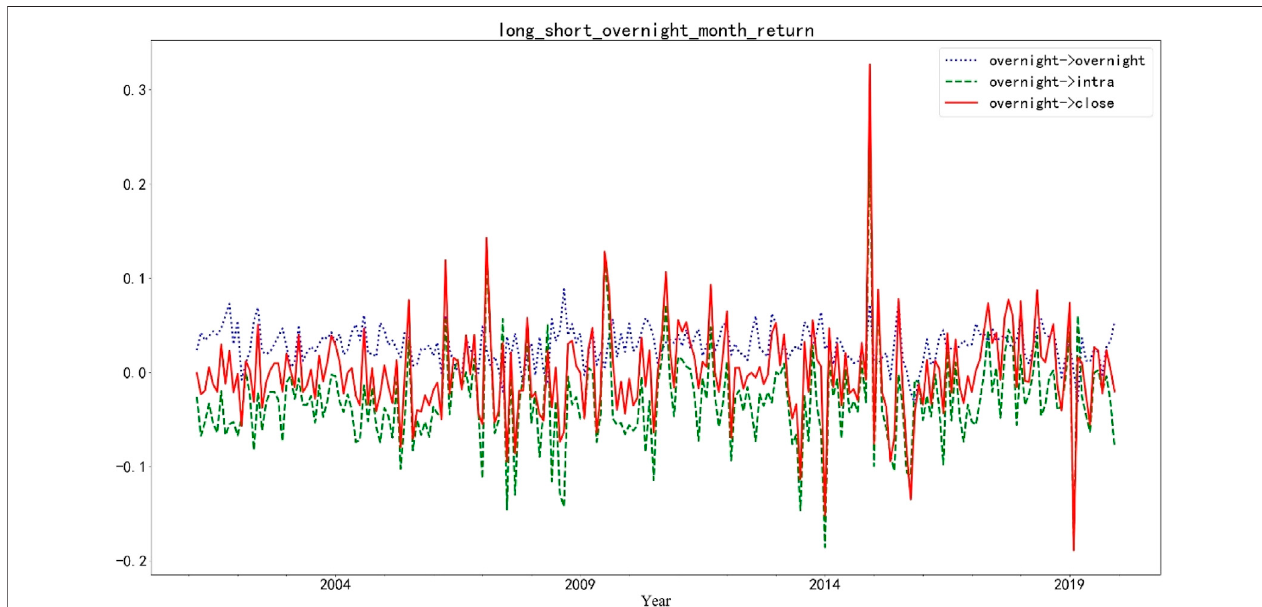
FIGURE1| This fi guredepictstheovernight-intradaypersistenceandreversalpatternreturnforenergyindustrystocks,asreportedinPanelAof Table2 .Theblue dotted curve corresponds to using 1-month lagged overnight returns to forecast the current overnight return. The green dashed curve corresponds to using lagged overnight returns to forecast the current intraday return. The red solid curve corresponds to using lagged overnight returns to forecast the current close-to-close return.